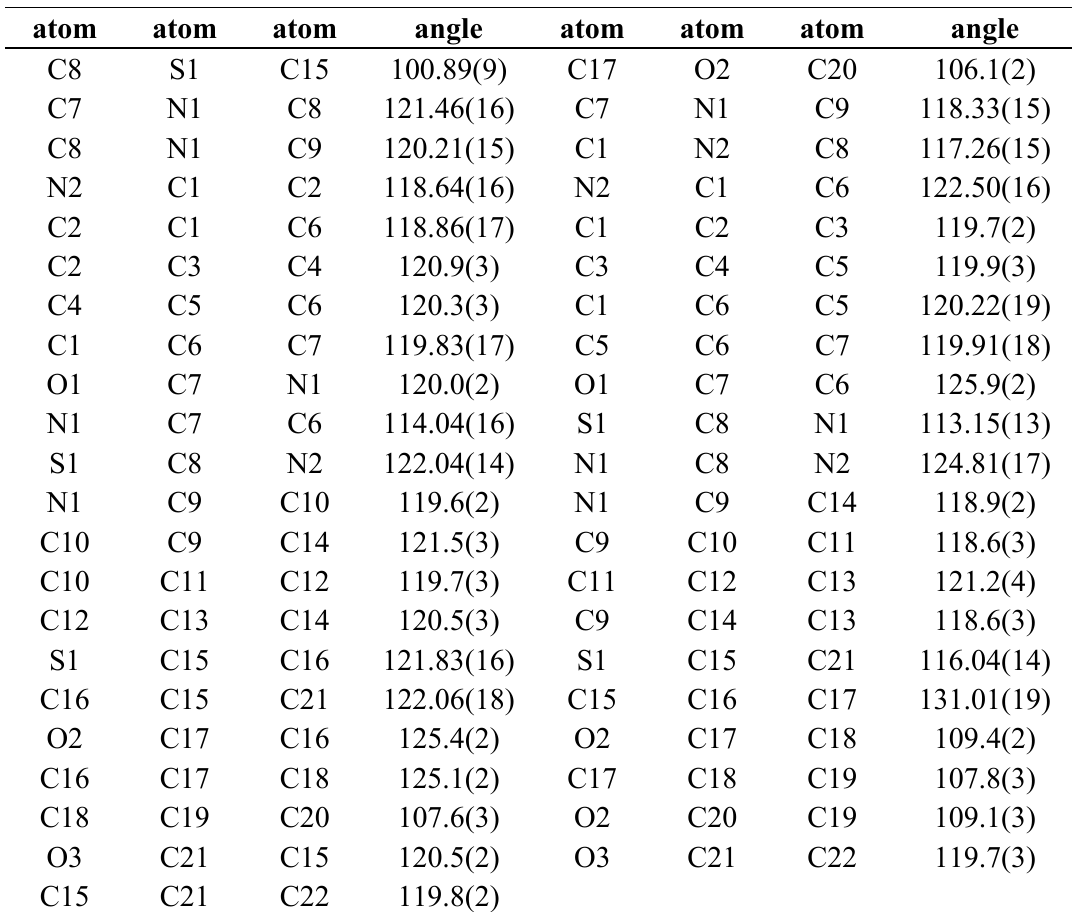
Table 12. Bond angles (o) for compound 10